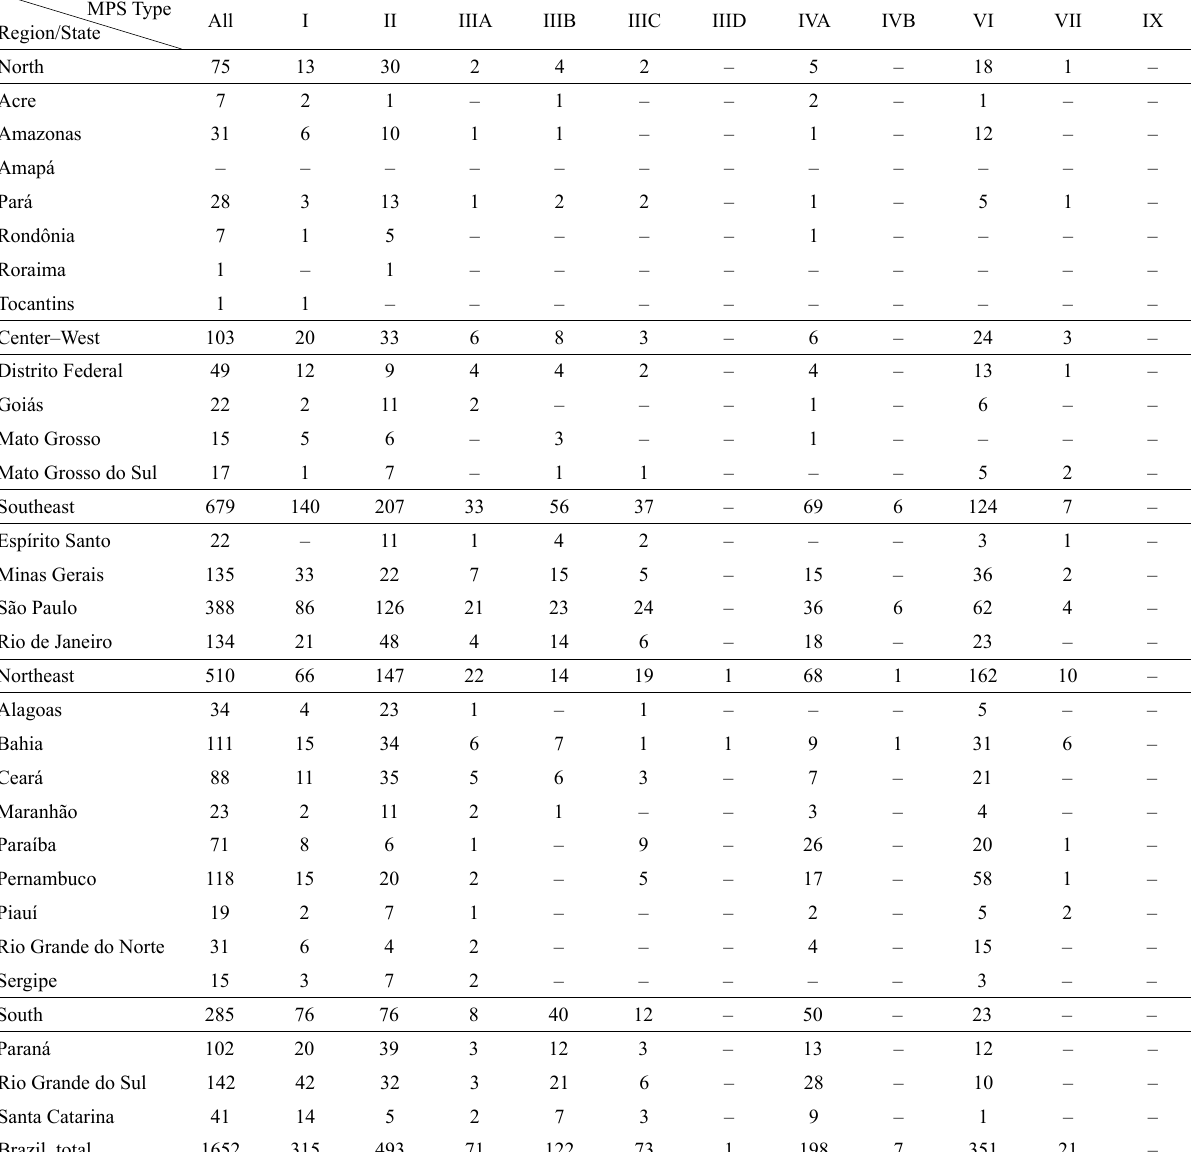
Table 1 – MPS types diagnosed in Brazil per region and by state a from 1982 to